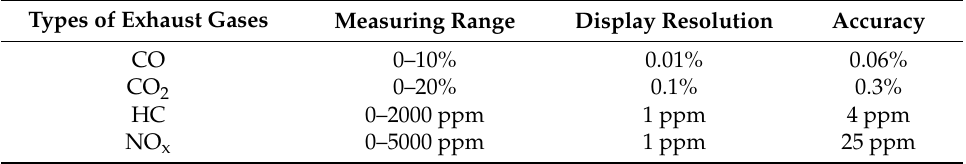
Table 4. Technical data of the exhaust gas analyzer (EMS 5003).